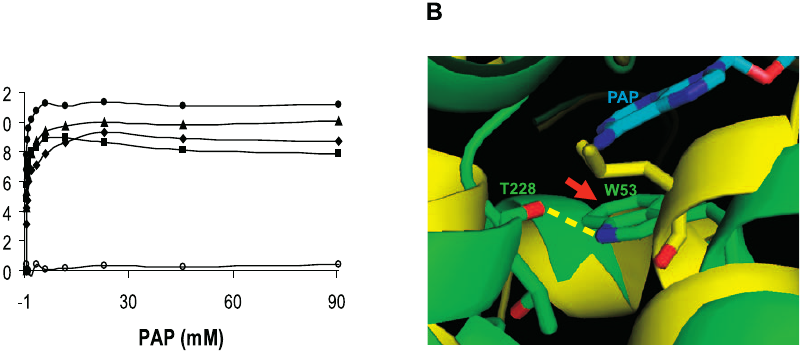
Figure 7. SULT4A1 Does Not Bind PAP (A) Thermal aggregation temperatures for SULT1B1 (filled circle), SULT1C3 (filled triangle), SULT1C1 (filled diamond), SULT1C2 (filled square), and SULT4A1 (open circle) as a function of PAP concentration. PAP provides no stabilizing effect to SULT4A1. (B) Superimposition of the PAP binding site of SULT1C1 (green) and SULT4A1 (yellow). A conserved Trp residue (W53 of SULT1C1; green ring in the middle of figure, indicated by a red arrow) normally forms p - p stacking interactions with the adenine ring of PAP (blue) and hydrogen bonds to a neighbouring conserved Thr (T228 in SULT1C1). SULT4A1 is the only SULT to have a Leu instead of Trp at this position. The Leu residue cannot make stabilizing interactions with Thr or the adenine ring, and its position would cause a severe steric clash with PAP and